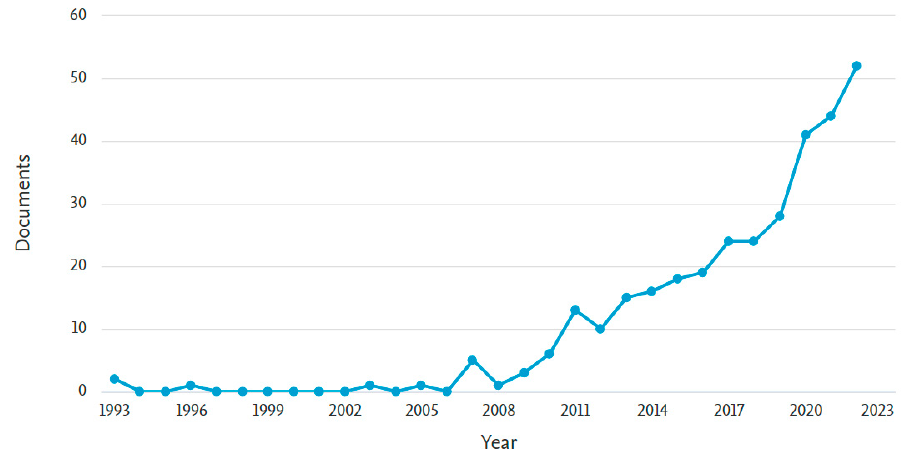
Figure 2. Annual distribution of the number of articles after Scopus search for the selected keywords and criteria. Figure source: Scopus.